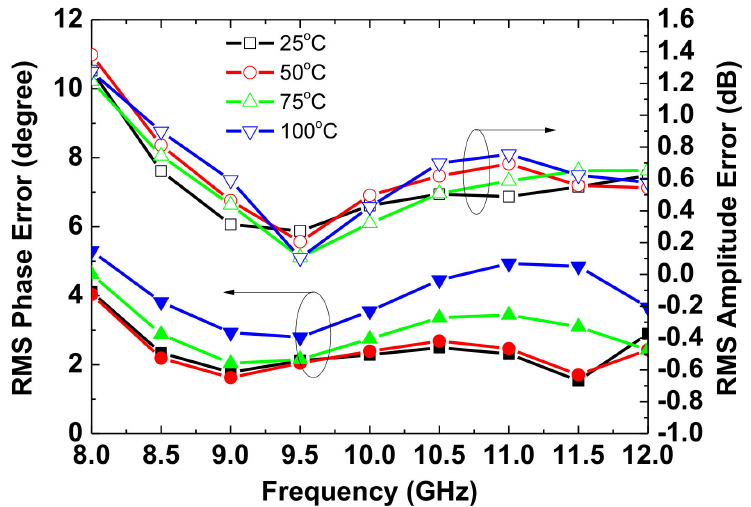
Figure 12. Temperature effect of the rms phase error and rms amplitude error of the five primary states of phase-shift at 25–100 ◦